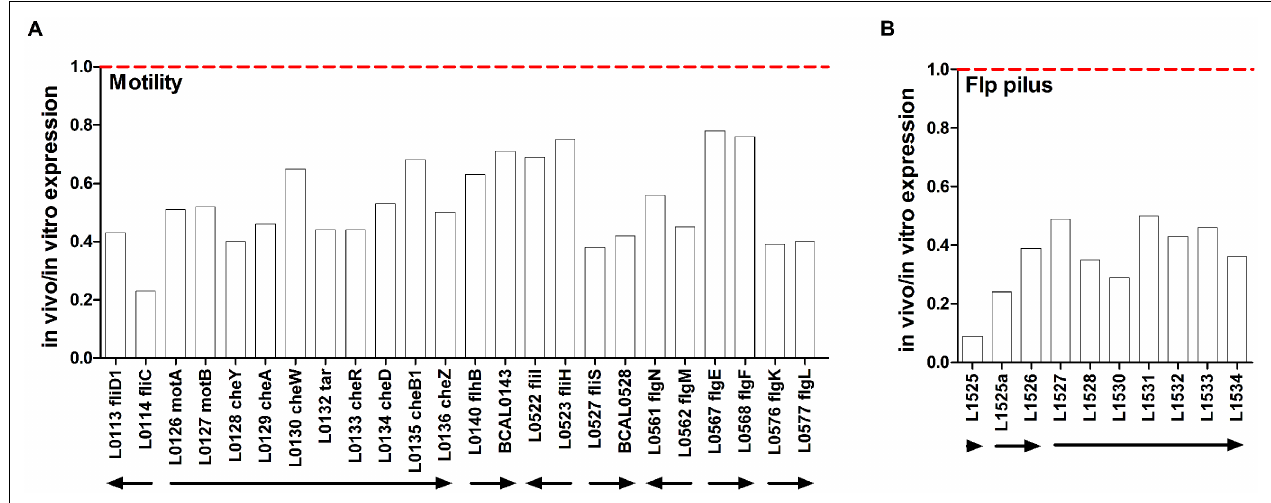
genes, (B) Flp type pilus genes.The “BCA” designation has been removed from names of genes encoded on chromosomes 1, 2, and 3 for image clarity. Putative operons are indicated by